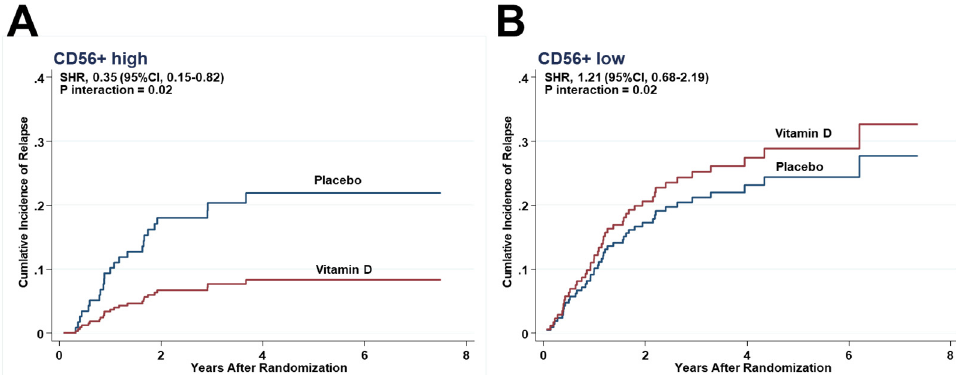
Figure 3. Effect of vitamin D on relapse by competing-risk analysis in the subgroup with the higher half of CD56+ cells ( A ) and the lower half of CD56+ cells ( B ). Cumulative incidence of relapse by competing-risk analysis in the subgroups of ( A ) CD56+ higher half, and ( B ) CD56+ lower half.